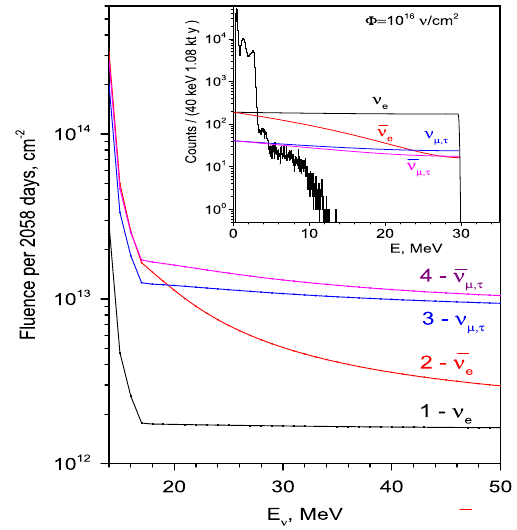
Fig. 7 The upper limits on the fluences of monoenergetic ν e ,μ,τ and ¯ ν e ,μ,τ with 1 MeV step (90% C.L.). The inset shows the Borexino data and the expected (ν x , e ) -scattering spectra for 30 MeV neutrinos